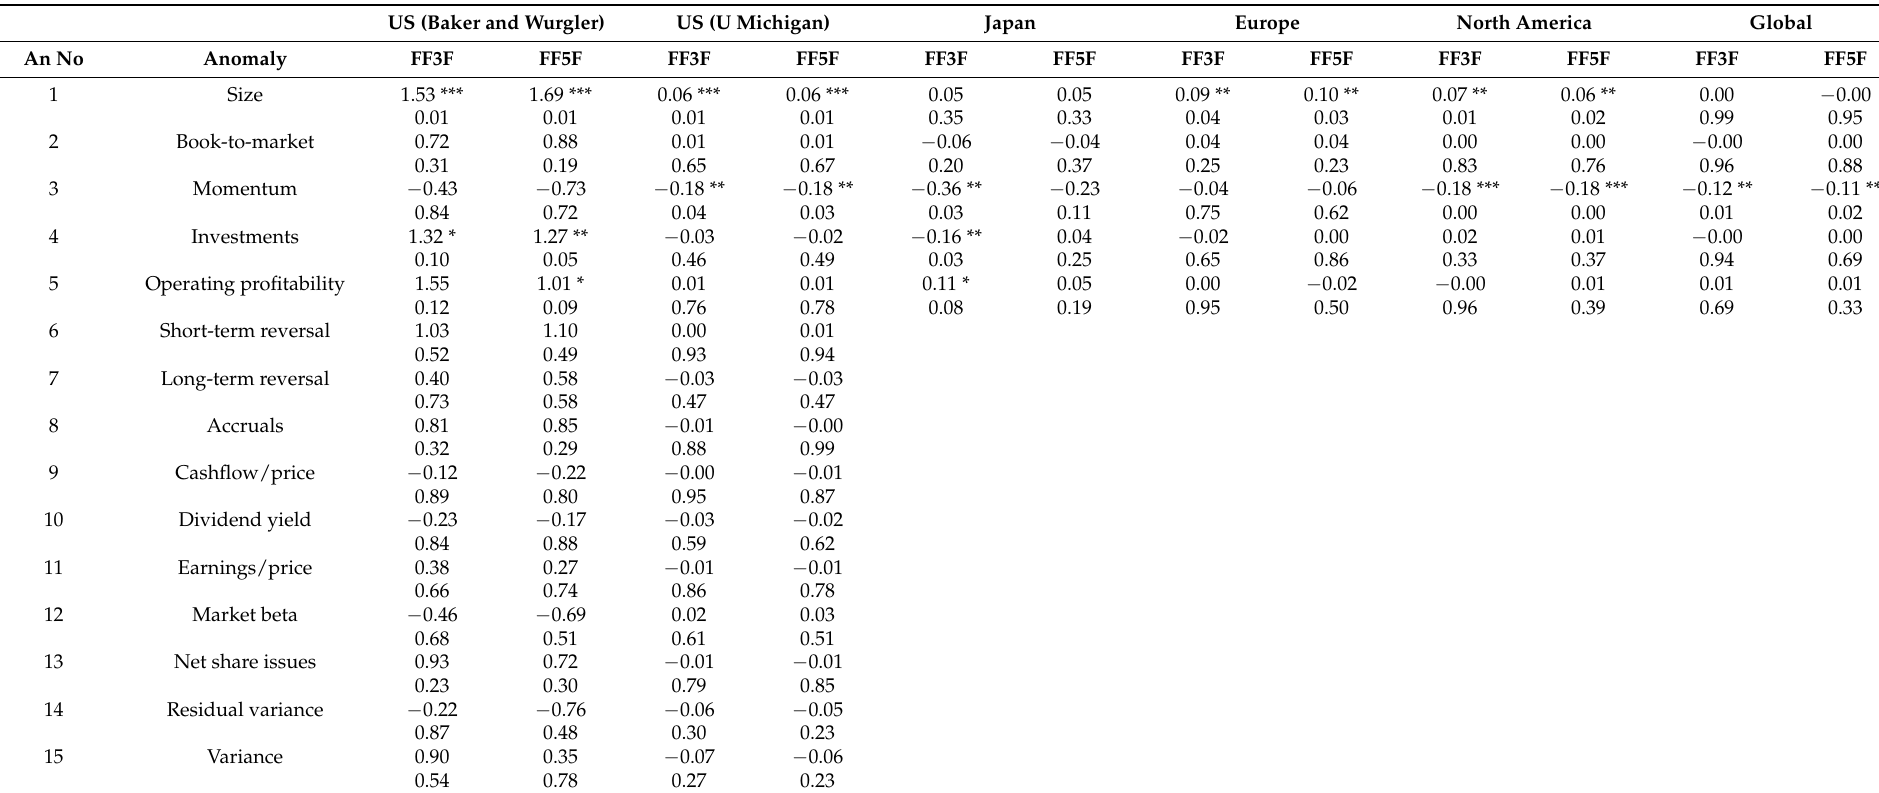
Table 7. Regression results: coefficient of the sentiment change variable in the augmented FF3F and FF5F